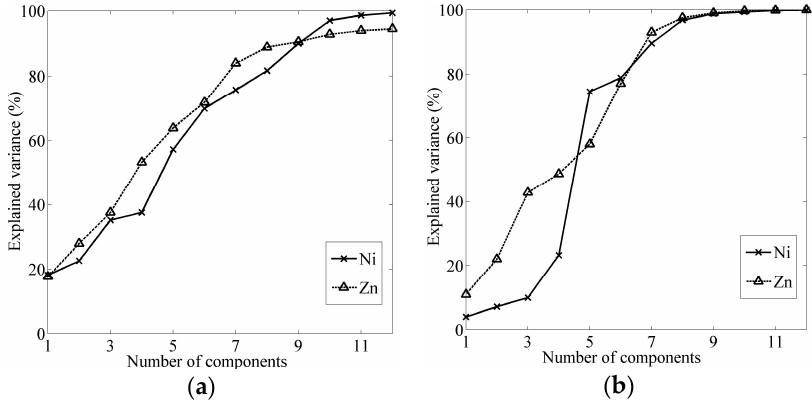
Figure 4. The explained variance of the element variables and variance increment for the respective number of components in the calibration set. ( a ) Is the explained variance and variance increments for calibration set of Group E1, and ( b ) is the explained variance and variance increments for calibration set of Group E2.